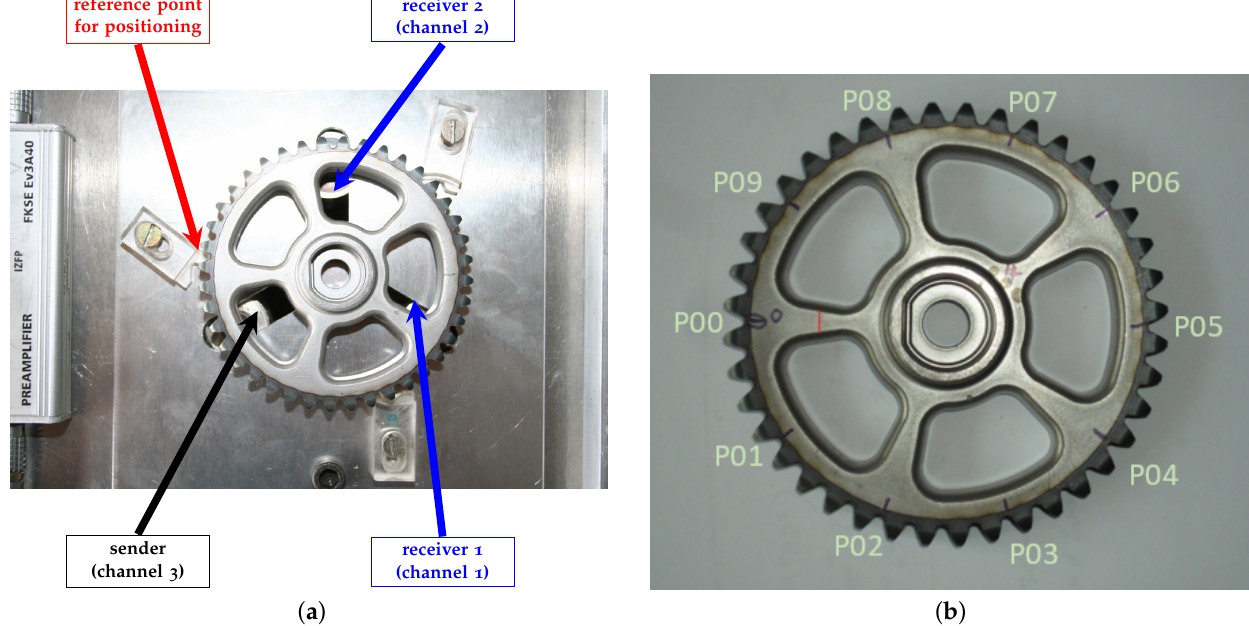
Figure 1. Acoustic measurement configuration of the cogwheel. ( a ) Test station for the acoustic measurement of the cogwheel; ( b ) Marked positions in the